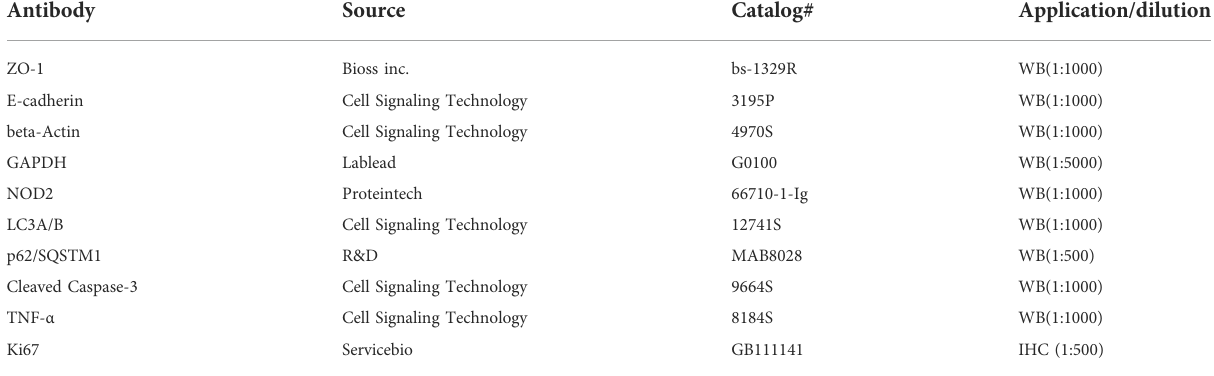
TABLE 1 Antibody